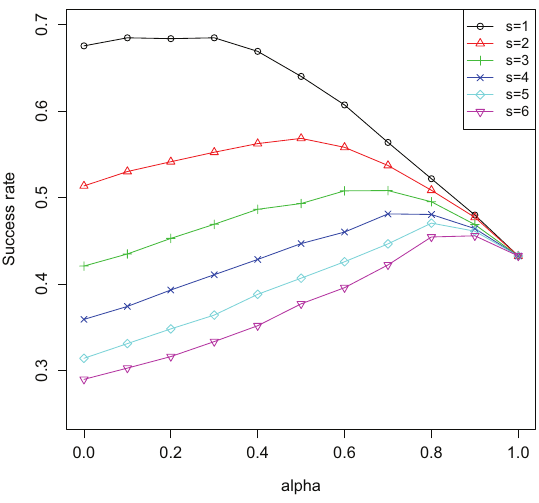
Fig. 3. Success rate, as a function of the parameter α , of the prediction of the best global optima in the Moving Peaks Benchmark using a linear combination described in Equa- tion 1, for different severity